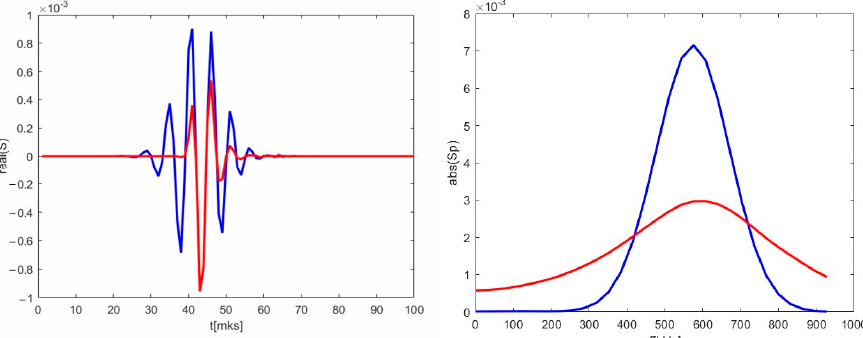
Figure 14. ( left ) DBS signals for the 48 GHz probing frequency; ( right ) calculated spectra of the signal on the left. The blue lines correspond to the reference signal from Figure 13. The red lines correspond to the calculations for trajectory in the middle in Figure 12.